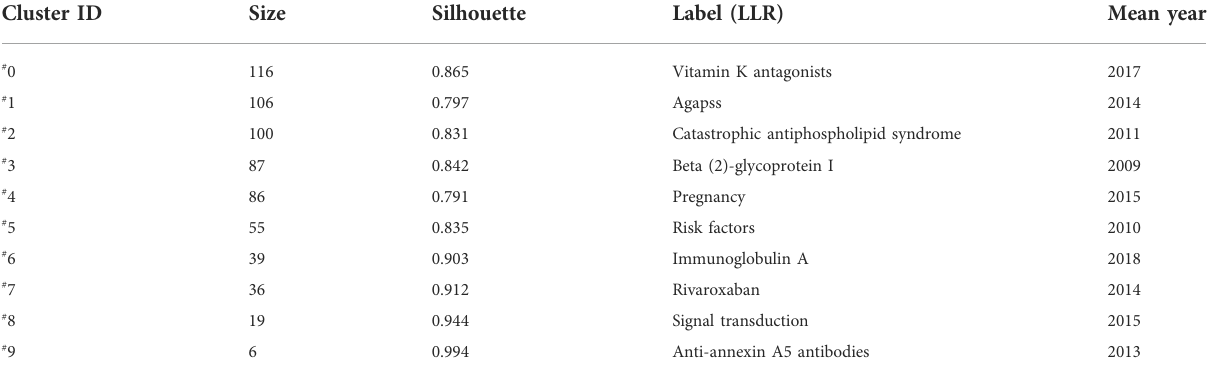
TABLE 8 The clusters information of co-cited references on